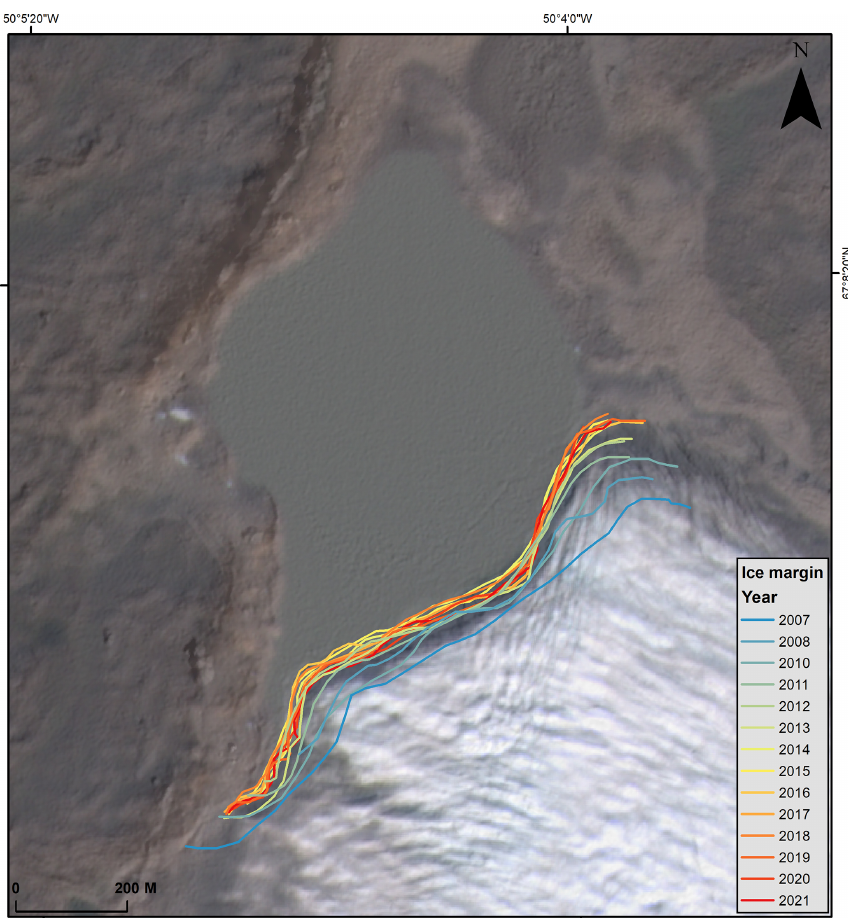
Figure A2. Position of ice margin digitized from satellite images. Background is a four-band Planet Team (2017) acquisition from 23 Au- gust